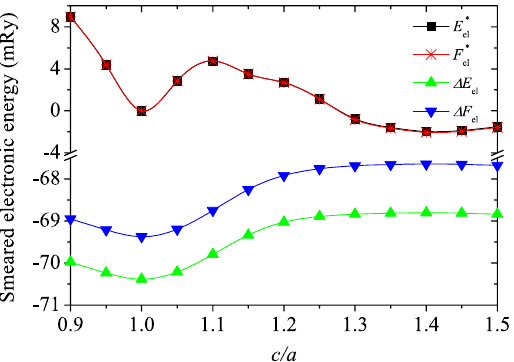
Figure 6. Smeared electronic energies ( ⁎ E and = − ⁎ ⁎ ⁎ F E TS ) and their differences relative to the static values el el el el ( ∆ = − ⁎ E E E and ∆ = − ⁎ F F F ) with respect to c / a of Pu. The ε phase ( c / a = 1) is used as reference for el el el el el el both the ⁎ E and ⁎ F el el